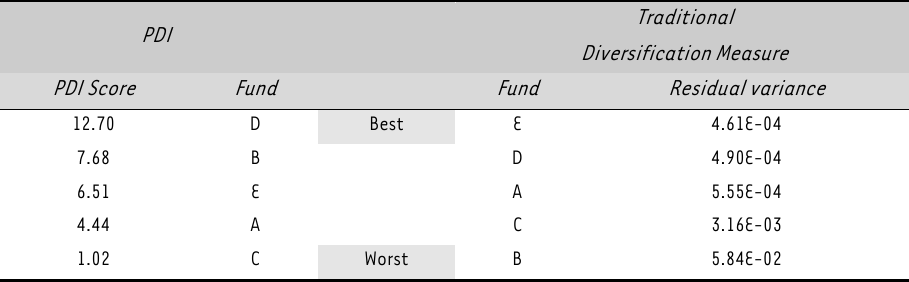
TABLE 2: PDI and traditional diversification measure results PDI